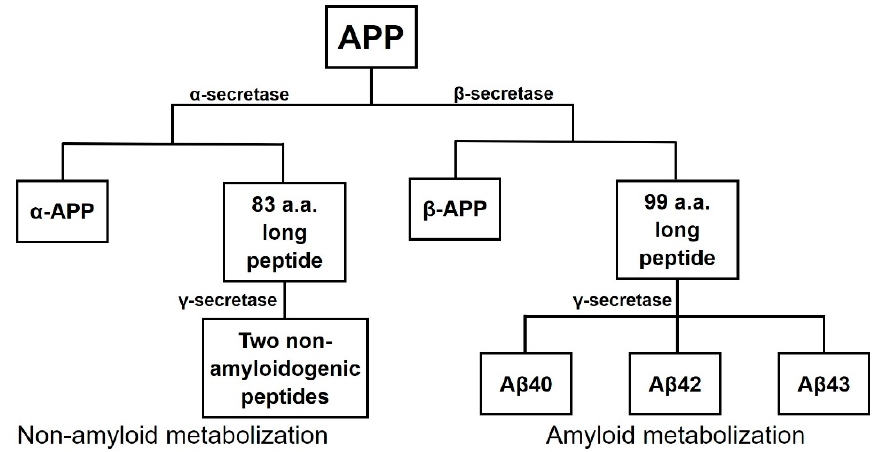
Figure 1. Scheme of cleavage of amyloid precursor protein (APP) through two possible metabolic pathways, the non-amyloid metabolization and the amyloid metabolization. Adapted from [5]. NFTs are formed from hyperphosphorylated tau protein, a protein that stabilizes the microtubules but which, when hyperphosphorylated, accumulates into tangles [4,6]. The main enzyme involved in the process is glycogen synthase kinase 3 β (GSK-3 β ) and its inhibition can lead to a reduction in tau hyperphosphorylation. GSK-3 β can be inhibited by protein kinase C (PKC), which is stimulated by muscarinic receptor 1 (M1) agonists such as acetylcholine